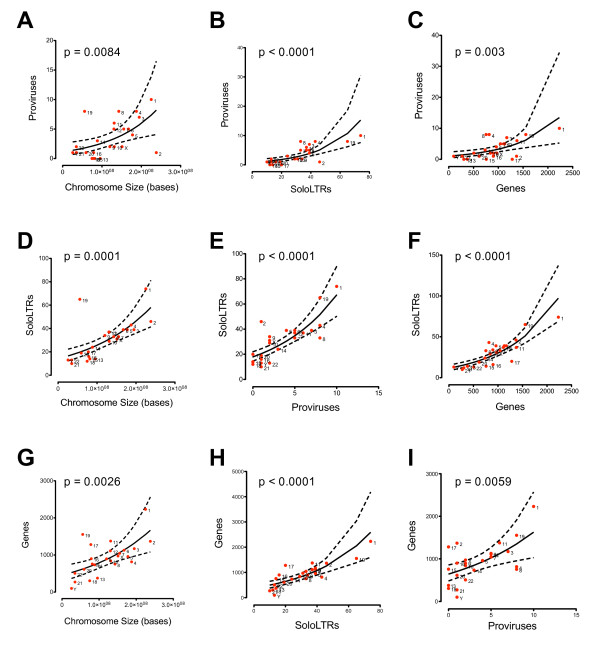
Relationships between chromosome size, solo LTR, provirus or RefSeq gene frequency. Binomial regression analysis was performed using chromosome size (A), solo LTR frequency (B), or RefSeq gene frequency (C) as a predictor of provirus frequency; or predicting solo LTR frequency using chromosome size (D), provirus frequency (E), or RefSeq gene frequency (F); or predicting RefSeq gene frequency using chromosome size (G), solo LTR frequency (H), or provirus frequency (I). The bold line represents mean correlation, with 95% confidence intervals shown with dashed lines. P-values are shown for each plot.